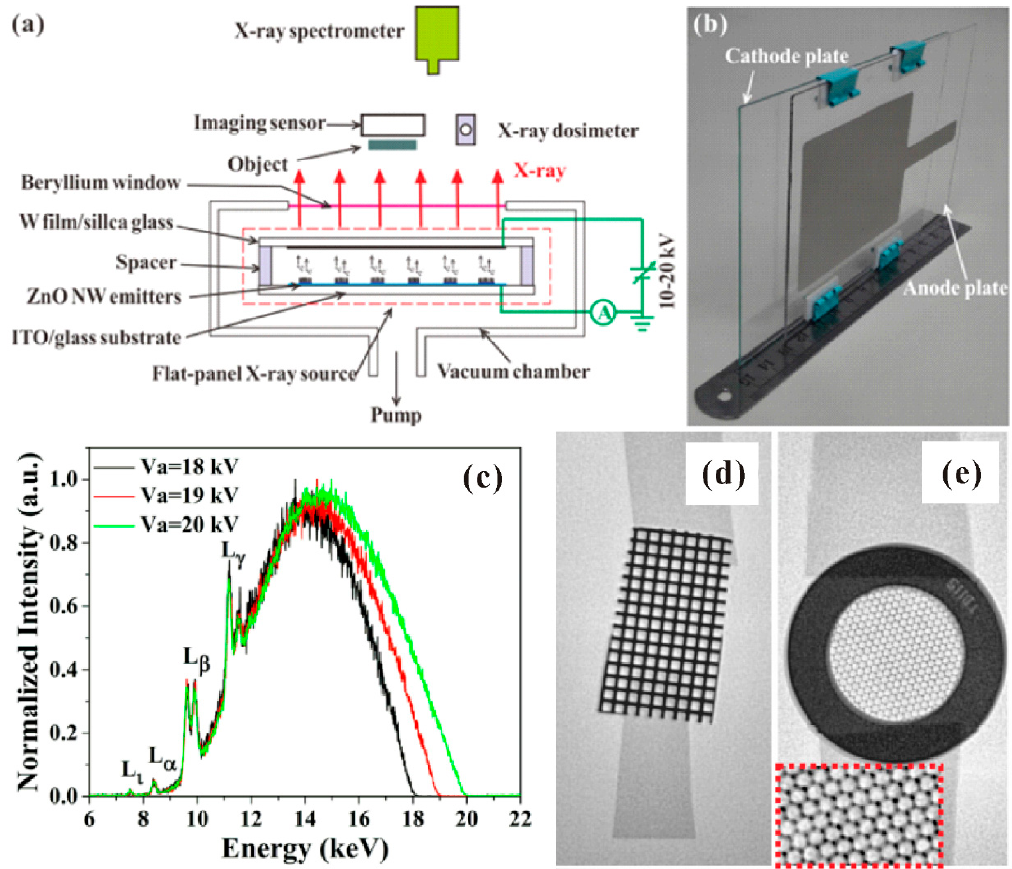
Figure 34. Flat-panel X-ray source based on ZnO nanowires. ( a ) Schematic diagram for the device structure. ( b ) Optical image of the device. ( c ) X-ray energy spectra. X-ray image of a metal mesh with linewidth of 200 μ m ( d ) and 25 μ m ( e ). Reproduced from [109], with the permission of AIP Publishing, 2015.